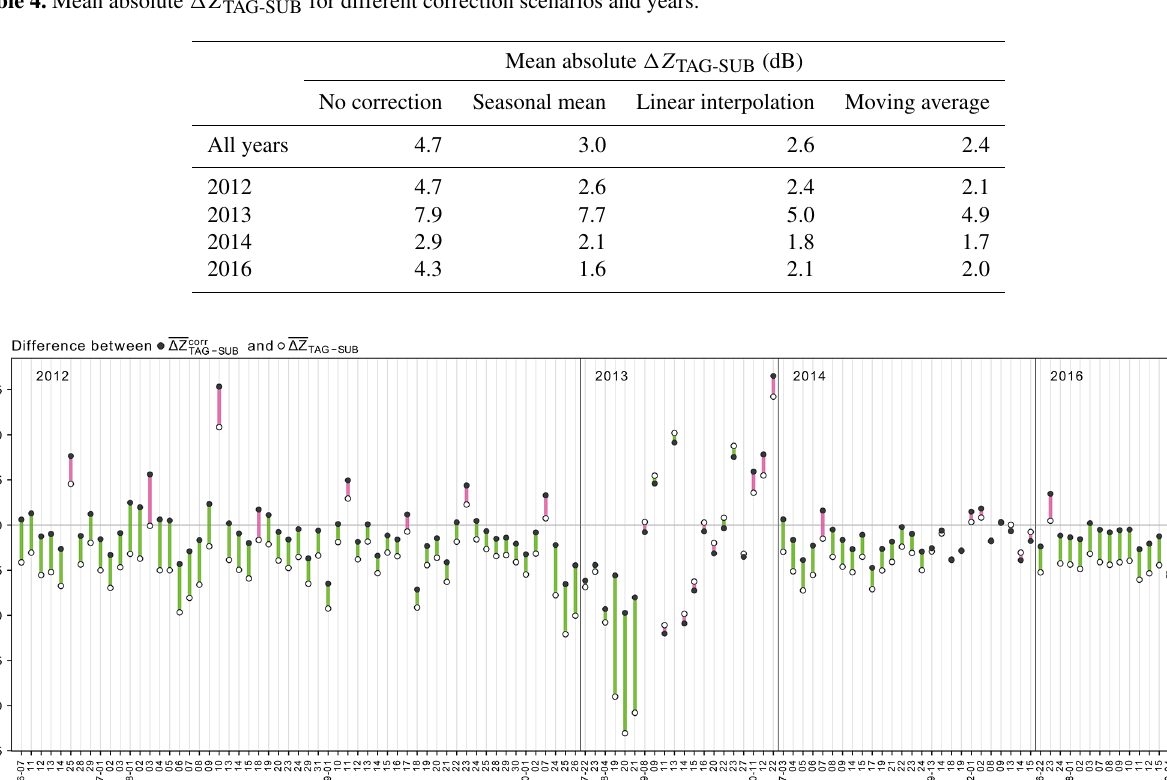
Table 4. Mean absolute (cid:49)Z TAG-SUB for different correction scenarios and years.